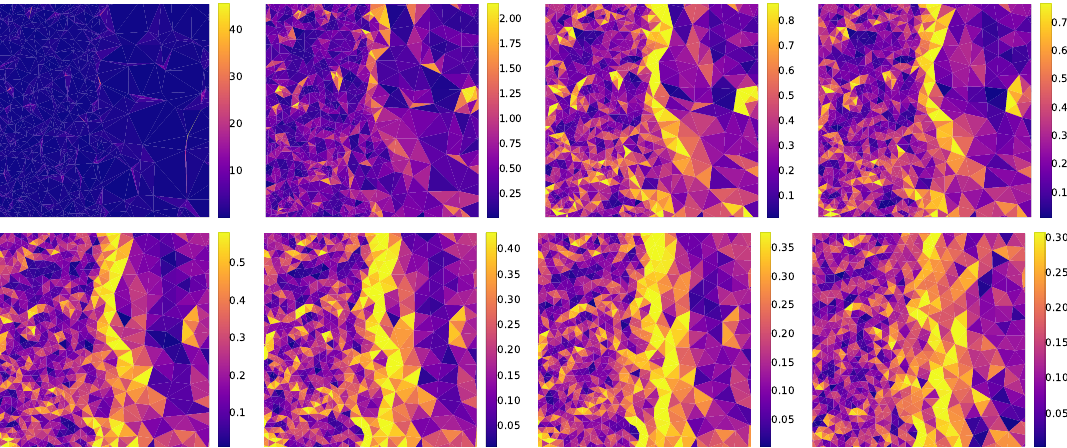
Figure 8 . Delaunay triangulations with individual cells color-coded by their rescaled gradient magnitudes ˜ G α , after a certain number of Lloyd steps (from top left to bottom right): 0, 1, 2, 3, 5, 7, 10, 20. The color bar extends up to 60% of the largest ˜ G α value found in the data; any cell with a gradient magnitude above that threshold is colored yellow, essentially creating an overflow color bin. This was done in order to minimize the effect of outliers and better visualize the bulk of the cells with typical values.